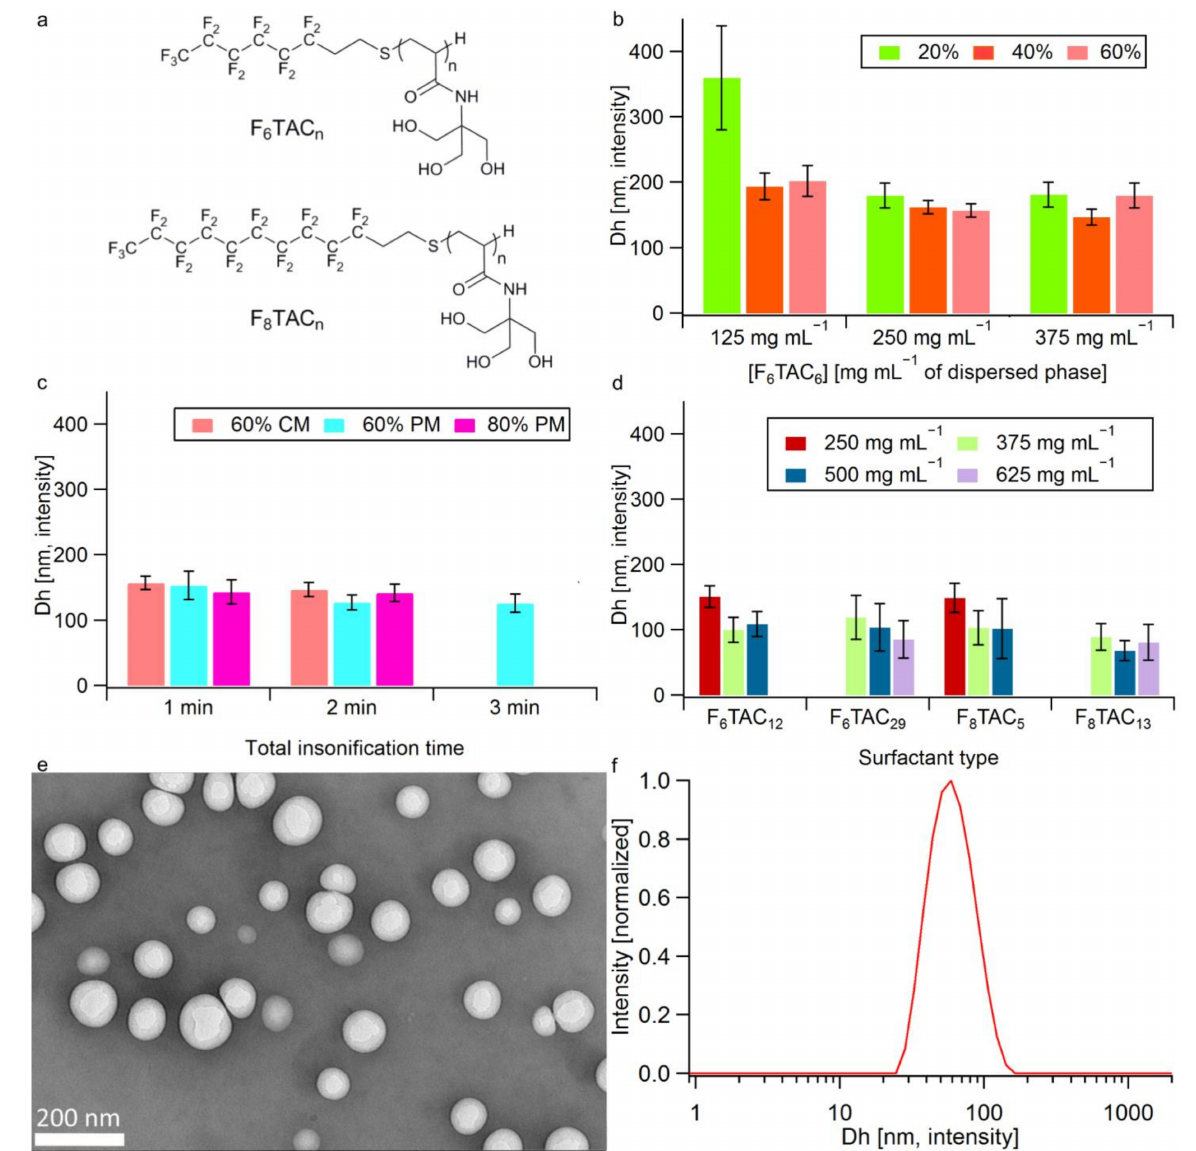
Figure 1. Structure of surfactants and droplet optimization experiments. ( a ) Structure of F-TAC surfactants. ( b , c ) Dh of droplets (Z-average), error bars mean peak distribution widths as given by √ σ = Z * PDI) as a function of ( b ) F 6 TAC 6 concentration at 20%, 40%, 60% US amplitude (contin- uous mode, 1 min). ( c ) Insonification time, US amplitude and mode (CM: continuous mode; PM: pulsed mode), emulsion made with F 6 TAC 6 at 250 mg mL − 1 of dispersed phase. ( d ) Dh of droplets (Z-average) as a function of surfactant type and concentration in mg per mL of dispersed phase (at 60% US amplitude i.e., 450 W, PM, 2 min). ( e ) TEM images of concentrated emulsion after rehydration (mean diameter 83 ± 18 nm). ( f ) DLS spectrum of sample. ( e ) (Contin analysis). The optimization of US parameters was performed with F 6 TAC 6 surfactant, specif- ically insonification duration, amplitude and mode (CM vs. PM). Figure 1b,c show that the droplet Dh tends to be inversely proportional to the F 6 TAC 6 concentration and US amplitude reaches a plateau at 250 mg mL − 1 (Figure 1b) and 60% (i.e., 450 W) (Figure 1c), respectively. Moreover, the PM (DC of 11.97% and pulse width of 8 s) provides smaller droplets compared to CM and the optimum insonification time is found to be 2 min, since larger Dh and no size improvements were observed at 1 min and 3 min, respectively (Figure